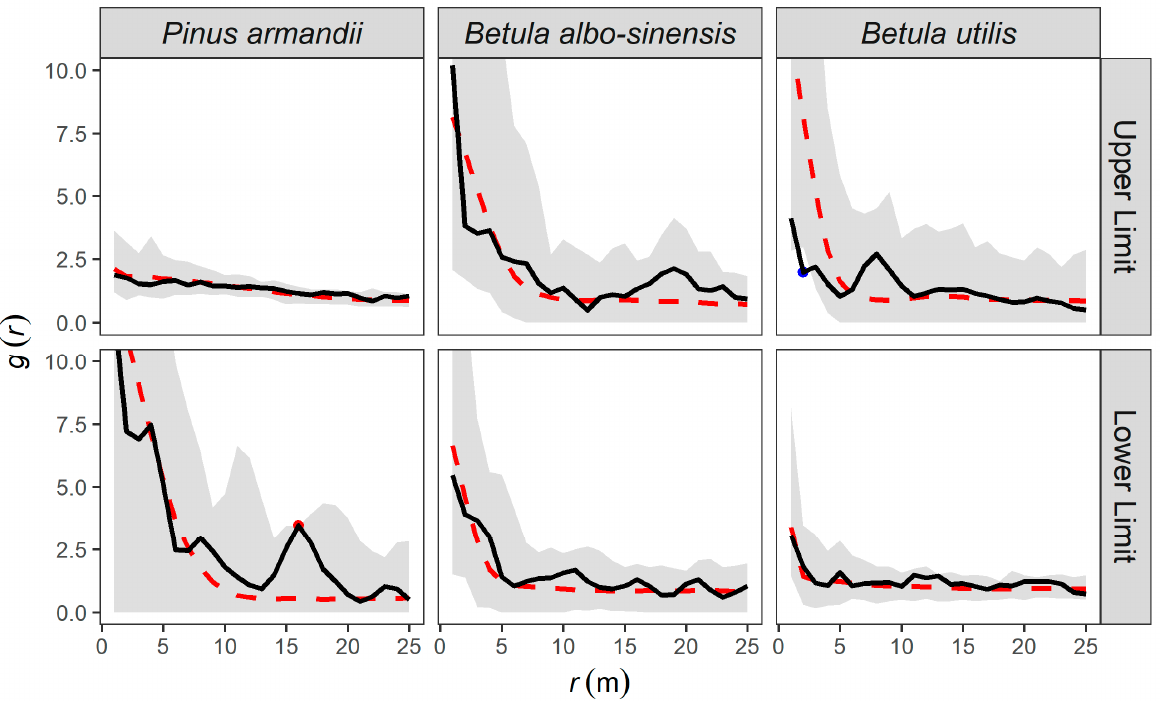
Figure 9. Inhomogeneous Thomas null model analysis of the spatial patterns of P . armandii , B . albo-sinensis and B . utilis in the sites from the upper and lower limits on treeline forest. Note: the red points are the g -values beyond the upper envelope at a corresponding scale, the blue points are the g -values under the lower envelope at a corresponding scale.